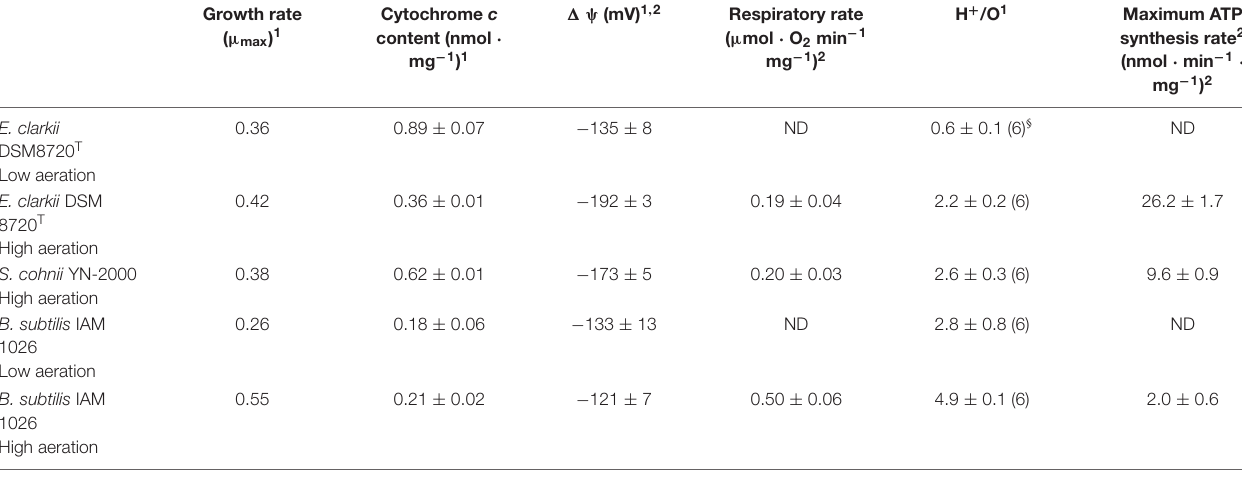
TABLE 2 | Summary for high aeration and low aeration in obligate alkaliphilic Evansella clarkii , facultative alkaliphilic Sutcliffiella cohnii , and neutralophilic Bacillus subtilis